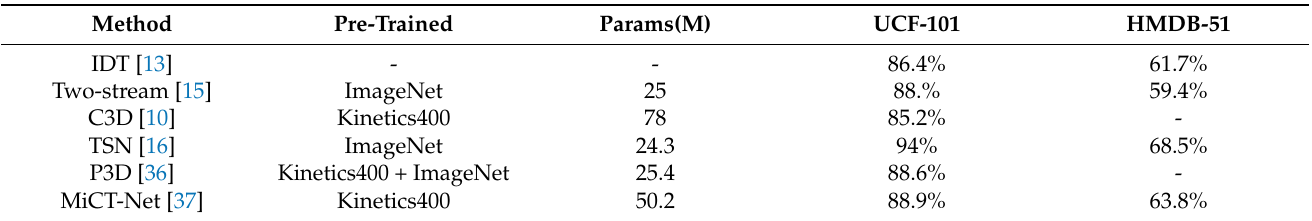
Table 3. Comparison of the state-of-the-art on UCF-101 and HMDB-51 datasets with only RGB frames as